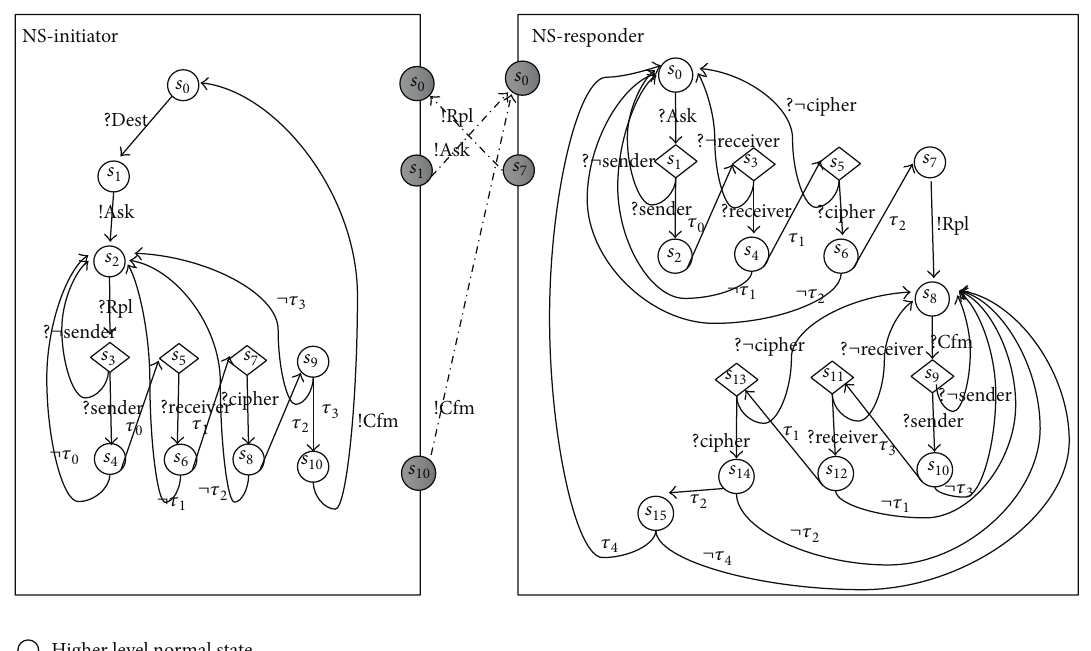
Figure 2: Glued security extension graph of